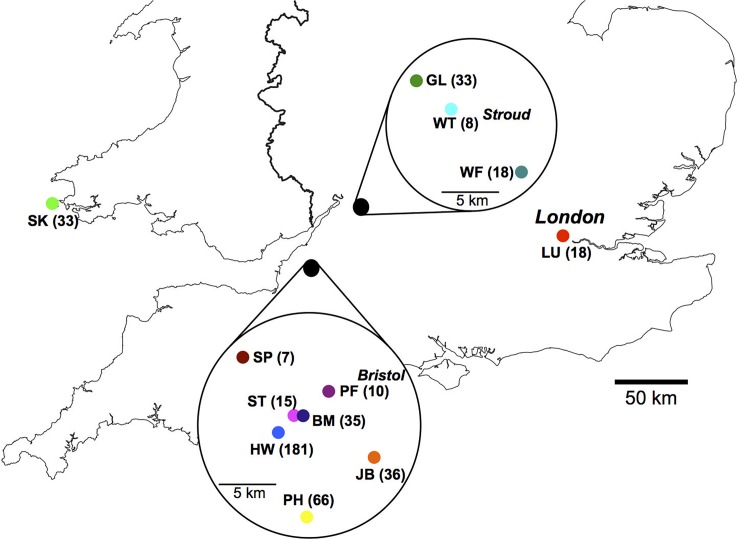
Wild mice were sampled from across the southern UK.The 12 sampling sites are shown by 2-letter designations, with the number of animals obtained at each site shown in parentheses.